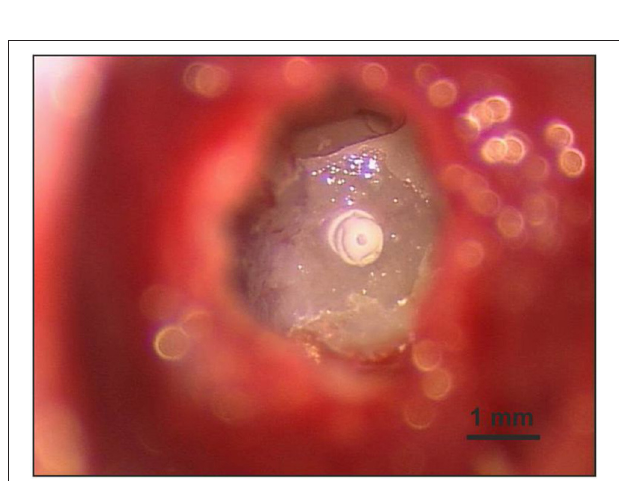
FIGURE 2 | A cochleostomy (0.4mm) was carefully drilled in the cochlear wall of the basal turn near the round window to obtain access to the scala tympani. The inserted silicone rod was fixed at the cochleostomy rim with histoacryl tissue